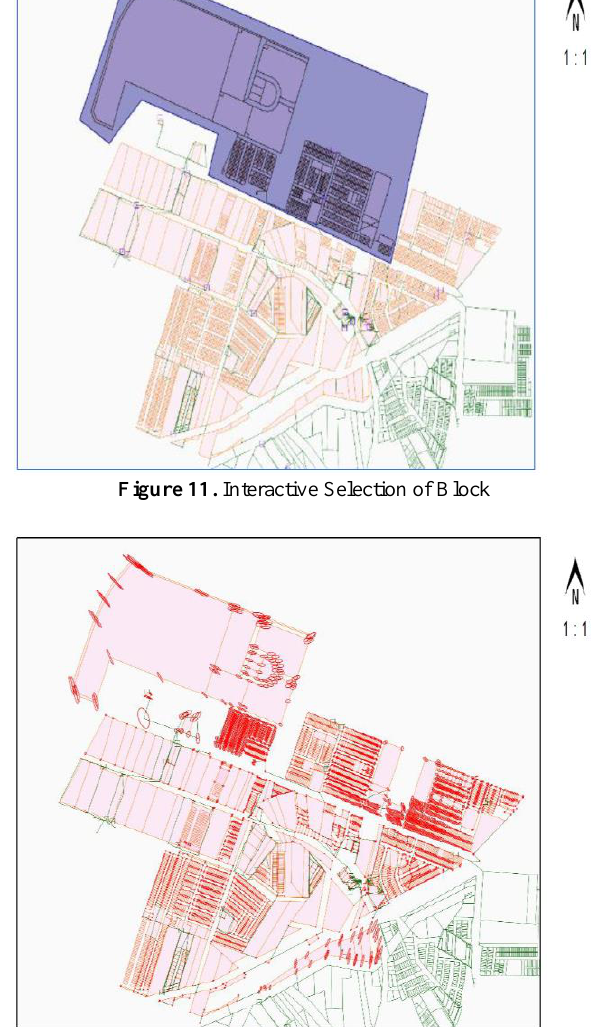
Figure 12. Adjustment Performed on Selected